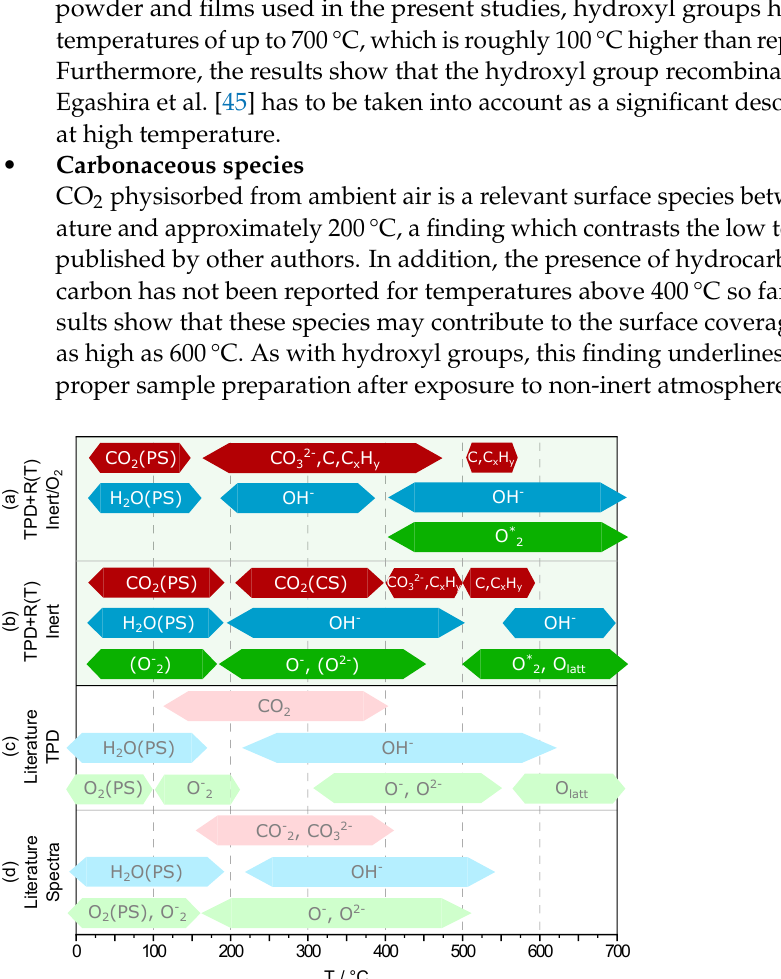
Figure 12. Overview of ITO surface species and corresponding temperature ranges identified by combining results of TPD and electrical resistance measurements for (a) inert and (b) oxygen rich atmosphere, compared to literature data for ITO, SnO 2 and In 2 O 3 obtained from (c) TPD and (d) spectroscopic studies. PS and CS refer to physisorbed and chemisorbed species, respectively, C denotes graphitic carbon, C x H y hydrocarbons and O * oxygen formed by the recombination of 2 hydroxyl groups. A species in parentheses indicates that the measurement results do not provide sufficient information to identify the particular